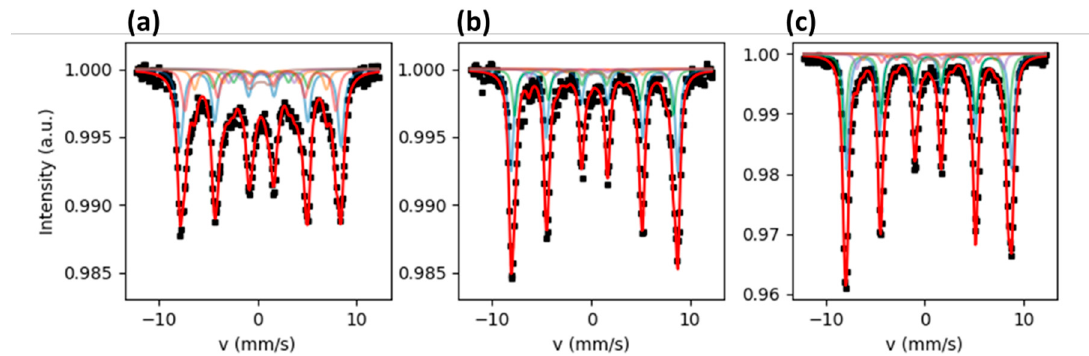
Figure 2. Mössbauer spectra of ( a ) Fe 3 O 4 NPs, ( b ) Fe 3 O 4 @Ag NPs, and ( c ) Fe 3 O 4 @Ag/TCS NPs obtained at 80 K. The solid lines represent the least square fits to the Mössbauer spectra for each site and the total spectrum.